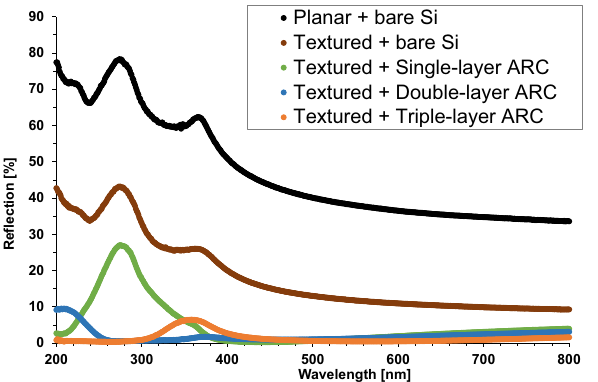
Figure 7. Reflection comparison of single-layer, double-layer, and triple-layer ARC on textured silicon surfaces. The bare planar and textured silicon surfaces are also included.